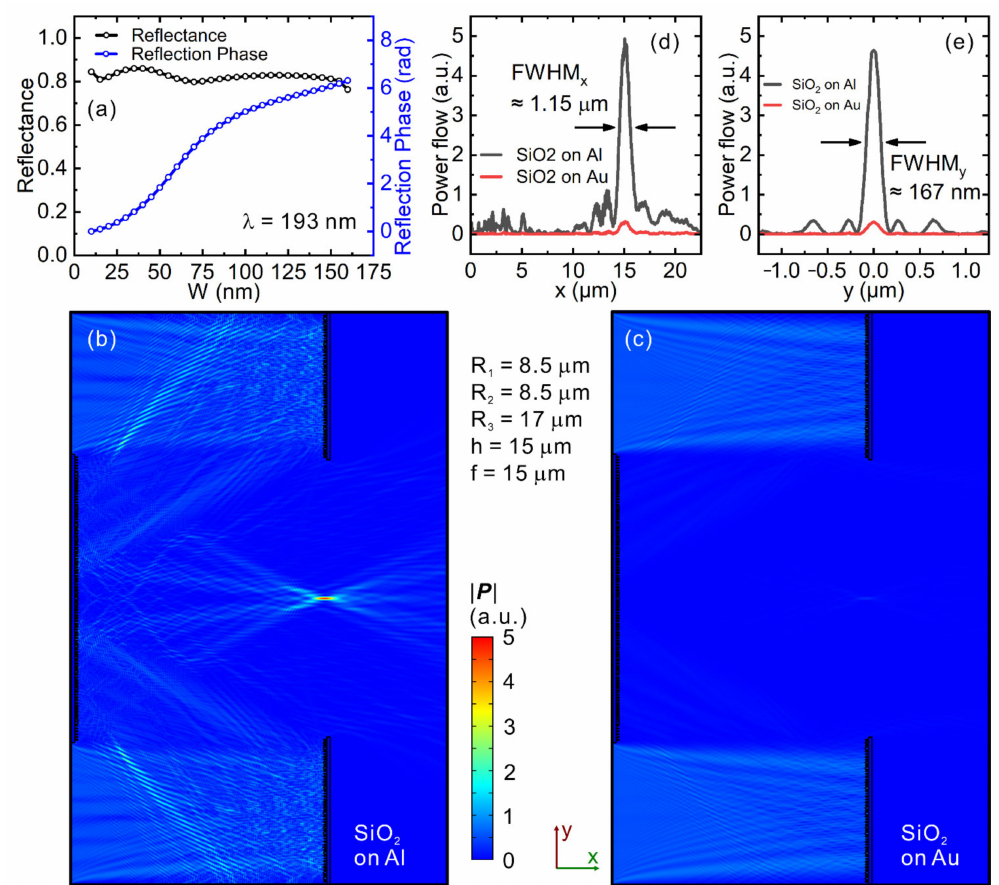
Figure A4. ( a ) Reflectance and reflection phases of the meta-atom unit cells with period P = 170 nm, height H = 190 nm and various widths (W). ( b ) Color map of energy flux of a metasurface Cassegrain telescope working at 193 nm wavelength with SiO 2 plus Al as the constituent material. The design parameters are R 1 = R 2 = 8.5 µ m, R 3 = 17 µ m and h = f = 15 µ m. ( c ) The same as ( b ) except that Al is replaced by Au while keeping all others unchanged. Note that ( b , c ) share the same color bar in the middle. Also shown are line-cut plots of the focus along ( d ) x- and ( e ) y-directions, respectively. It is obvious that Al outperforms Au in UV wavelength range in the sense of smaller optical loss and, thus, greater